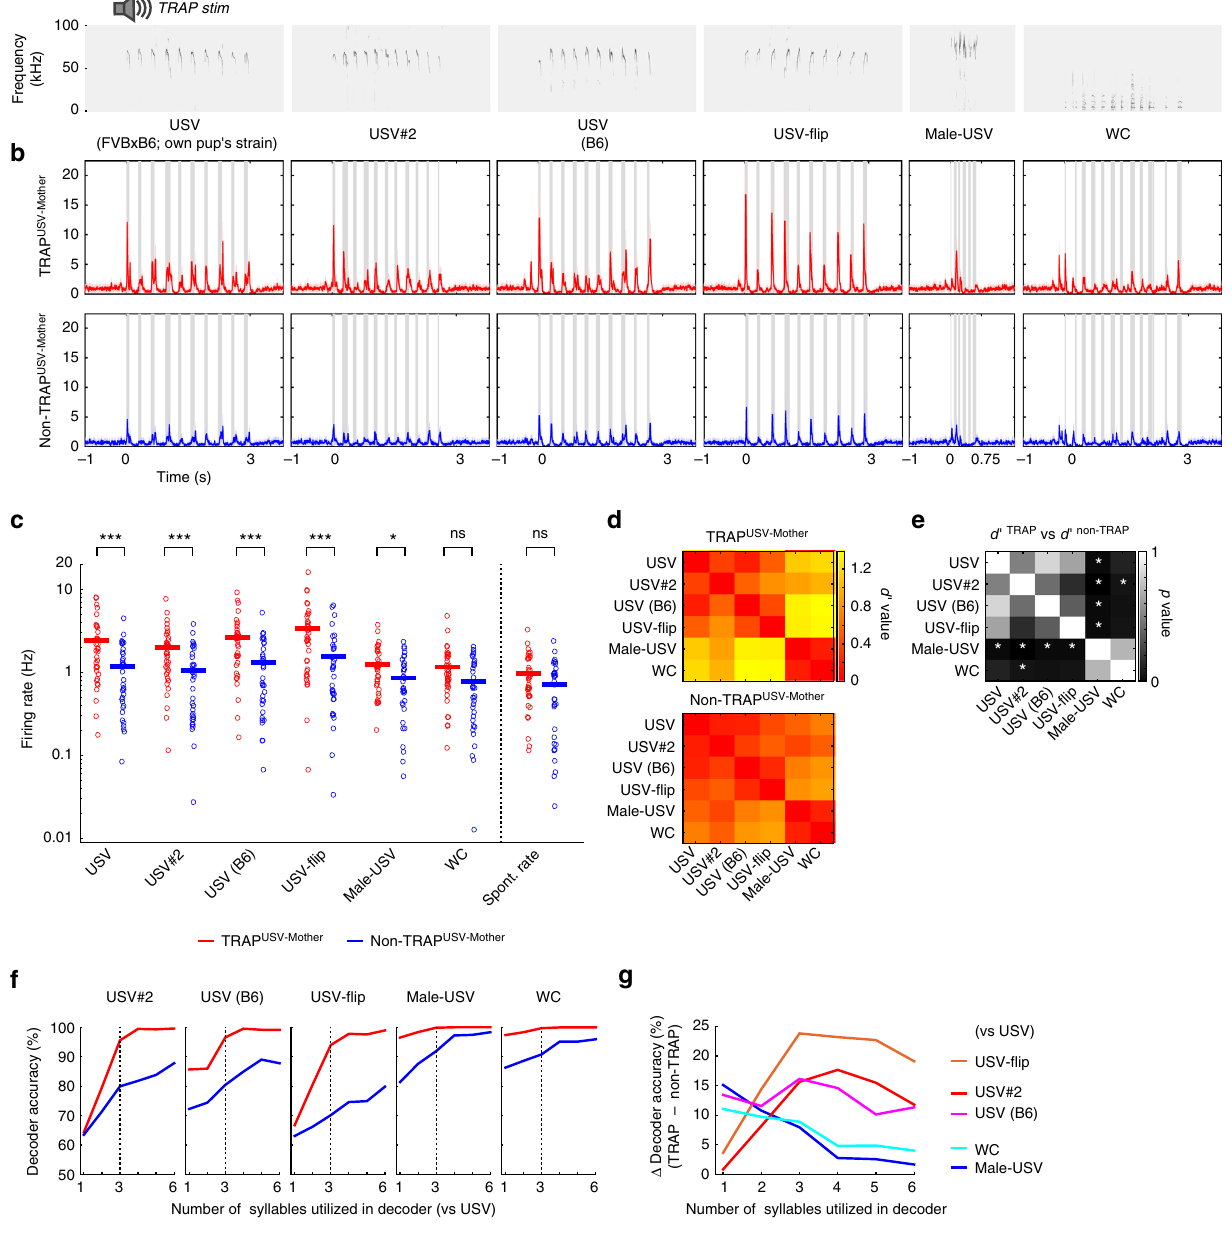
Fig. 7 USV-TRAPed neurons in mothers are promiscuous to and improve coding of pup USVs. a Spectrograms of the 6 different sound stimuli used to test responsiveness in this experiment (see Methods for details). b Average PSTHs calculated from all neurons in response to the 6 sound stimuli from the two neuronal groups in this experiment (TRAP USV-Mother ; n = 38 neurons (red), non-TRAP USV-Mother ; n = 35 neurons (blue), N = 6 mice). c Spontaneous and evoked response properties of all neurons from the two groups (each circle represents an individual cell and the line indicates the mean). Neurons TRAPed with USVs (TRAP USV-Mother , red) respond higher to a collection of USV ’ s and particularly the different variations of pup-USVs (* p < 0.05; *** p < 0.001; ns, not signi fi cant, post hoc Fisher ’ s LSD test after signi fi cant Kruskal – Wallis test). Spontaneous fi ring rates were not signi fi cantly different ( p = 0.09, Mann – Whitney U -test). d Matrices describing the average discriminability power of individual neurons between all combinations of different stimuli. Each pixel indicates the average d ’ value calculated from the evoked spike rate from all neurons to two different calls. Both groups have similar trend but TRAPed neurons have better discrimination power between pup USVs and male-USV or WC (bottom left of matrix). e P -values of a Mann – Whitney U -test comparing between the values of each pixel of the matrices shown in ( e ). Asterisks indicate p -values lower than 0.05. f Classi fi cation performance of a Support Vector Machine (SVM) decoder. The decoder was tested for its accuracy to differentiate between any one of 5 different stimuli against the TRAP stimulus (USV (FVBxB6)). The performance of the decoder is shown for the two different groups separately (red, TRAP USV-Mother ; blue, non-TRAP USV- Mother ) and plotted against the number of syllables it was trained on and allowed to use. After 3 syllables (dotted lines) TRAPed neurons reached near 100% accuracy in decoding all pairs. g A plot of the difference in decoding performance between the TRAP USV-Mother and the non-TRAP USV-Mother (red – blue in ( f )). The difference between the groups is more evident for the